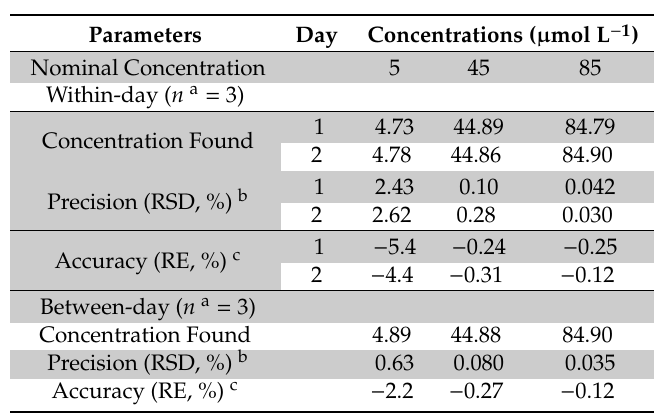
Table 7. Precision and accuracy of the proposed method for ethinyl estradiol determination.